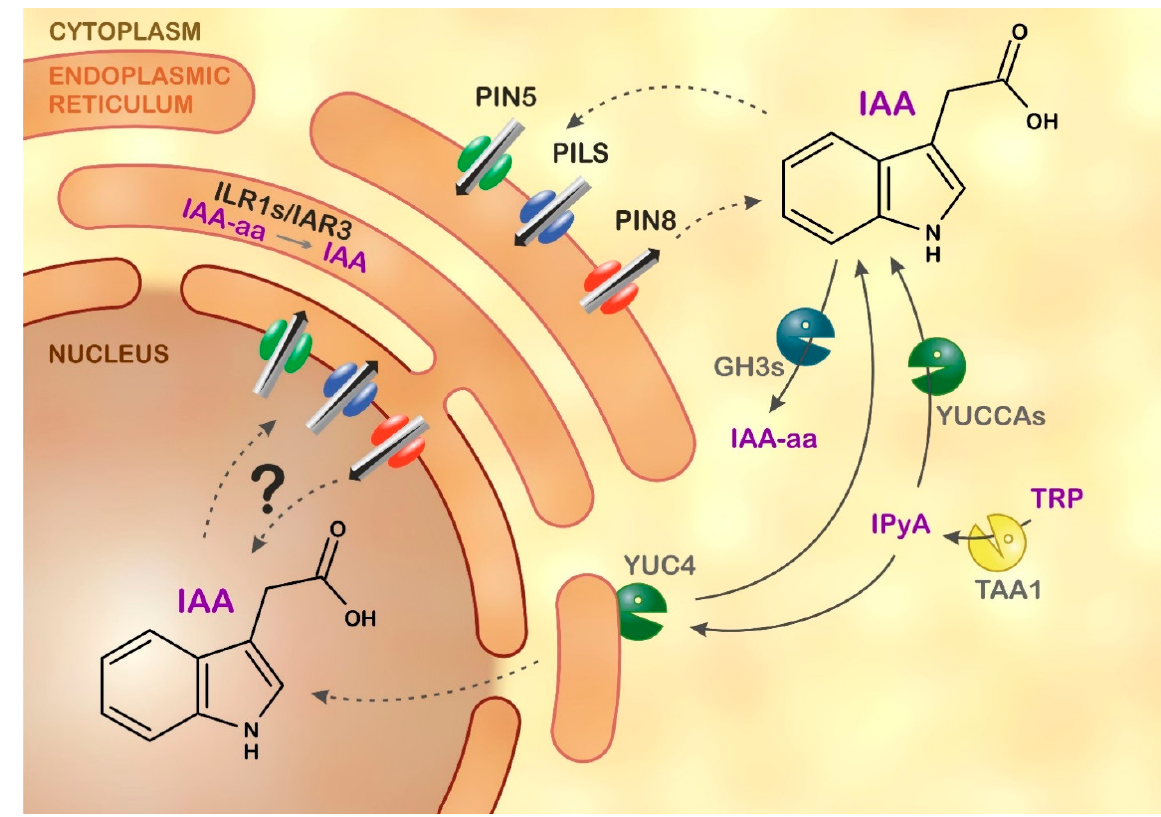
Figure 1. Model of auxin homeostasis in Arabidopsis endoplasmic reticulum (ER). Levels of active indole-3-acetic acid (IAA) are tightly regulated via biosynthesis, transport, and metabolism. Tryptophan (TRP) is converted to IAA via the TRYPTOPHAN AMINOTRANSFERASE OF ARABIDOPSIS/YUCCA (TAA/YUC) biosynthetic pathway, in which a key intermediate is indole-3-pyruvic acid (IPyA). Members of the PIN family of auxin transporter proteins (PIN5, PIN8) and PIN-LIKES (PILS) facilitate intracellular auxin transport. PIN5 mediates auxin flux from the cytosol to the ER lumen, whereas PIN8 acts in the opposite direction. IAA is inactivated by Gretchen Hagen 3 (GH3) proteins, which catalyse the formation of IAA-amino acid conjugates (IAA-aa). ER-localised auxin amidohydrolases (IAR3, ILL2 and ILR1) catalyse the reverse reaction, hydrolysing IAA-aa to active IAA. The ER membrane is in light brown, while the nuclear membrane is in dark brown. Solid and dotted arrows indicate enzymatic conversion or transport, respectively. “ ? ” means putative auxin transport.